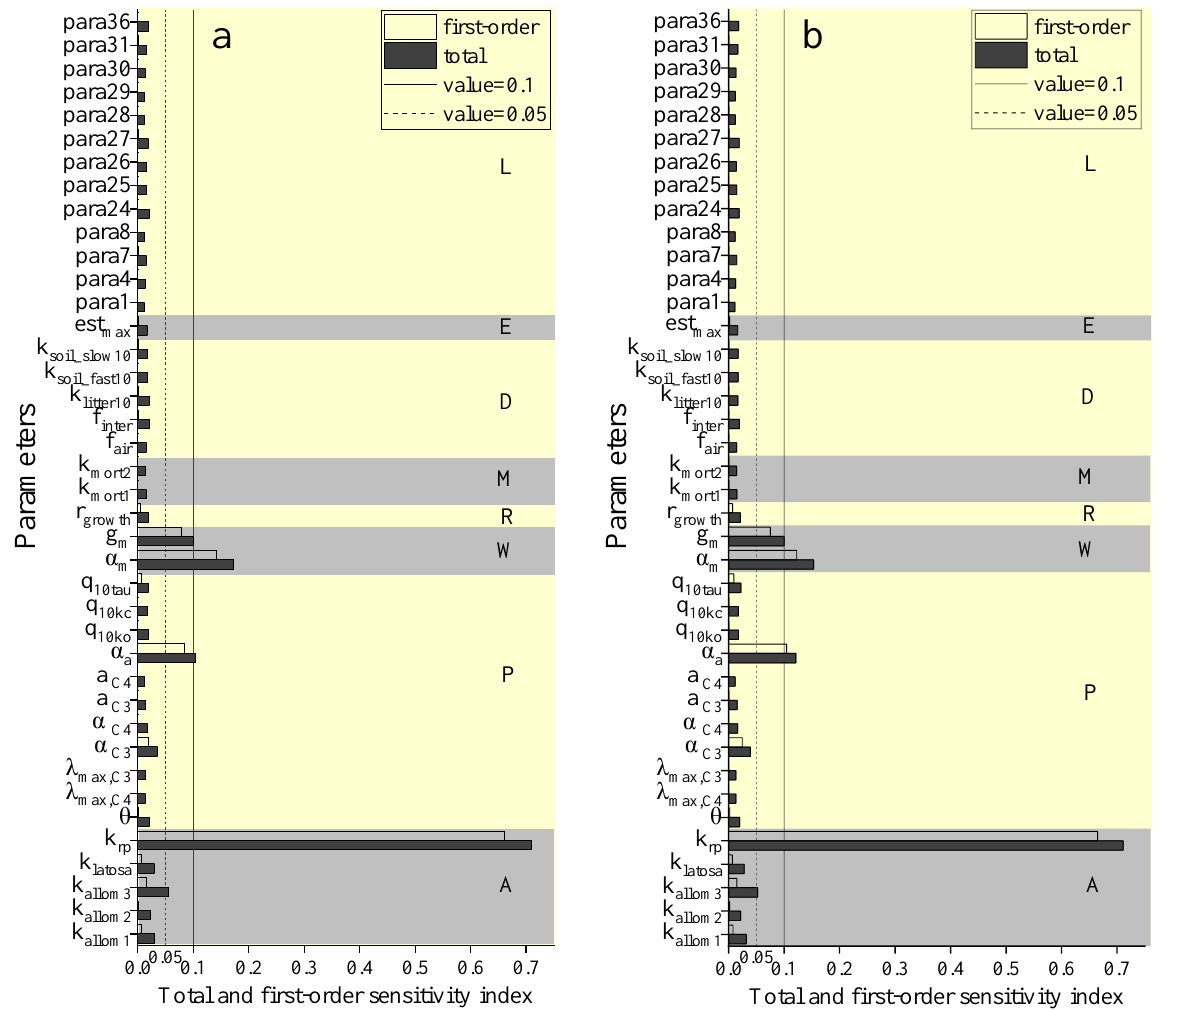
Figure 4. Global sensitivity index calculated by the EFAST method for NPP simulated by the LPJ model in 2009–2014 ( a ) and 2000–2019 ( b ). Note: Capital letters have the same meaning as above.